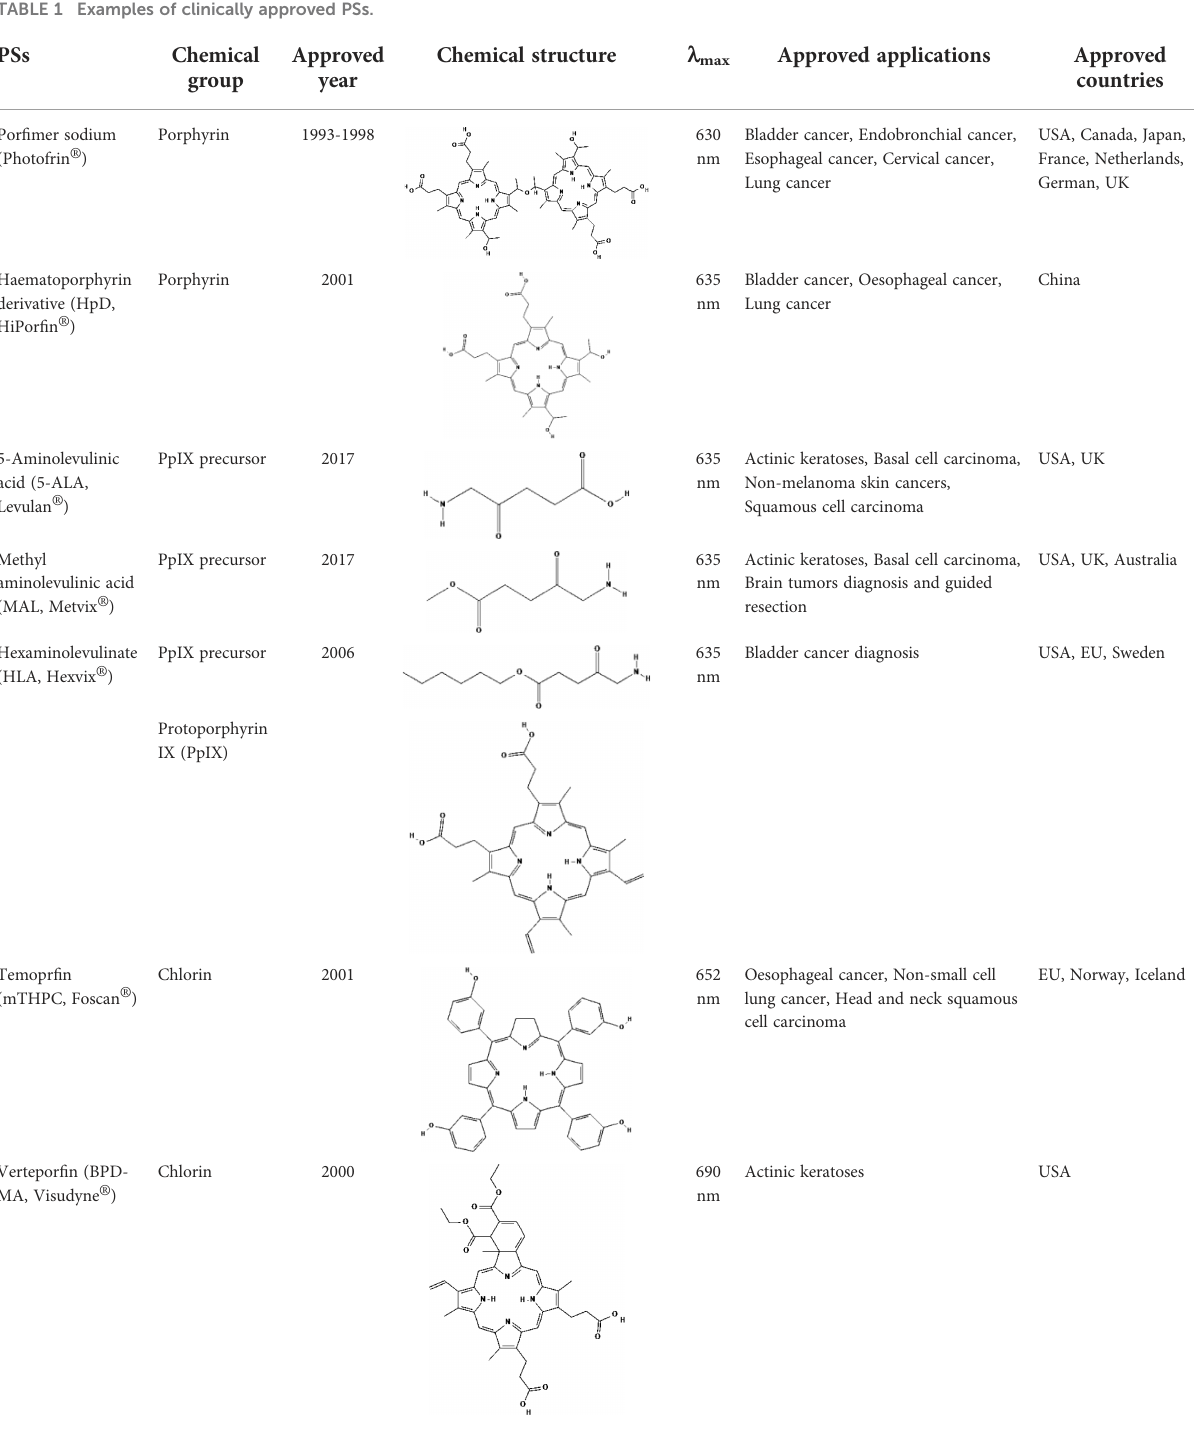
TABLE 1 Examples of clinically approved